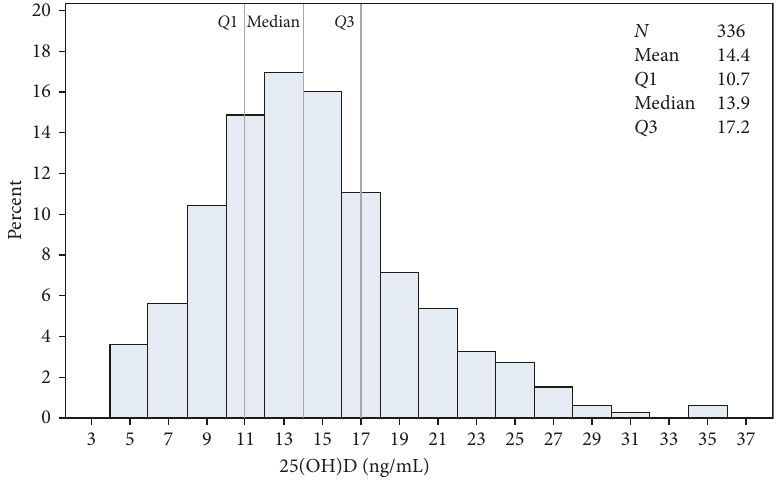
Figure 1: Distribution of the 25-hydroxyvitamin D (25(OH)D) concentrations across the entire study population ( n �